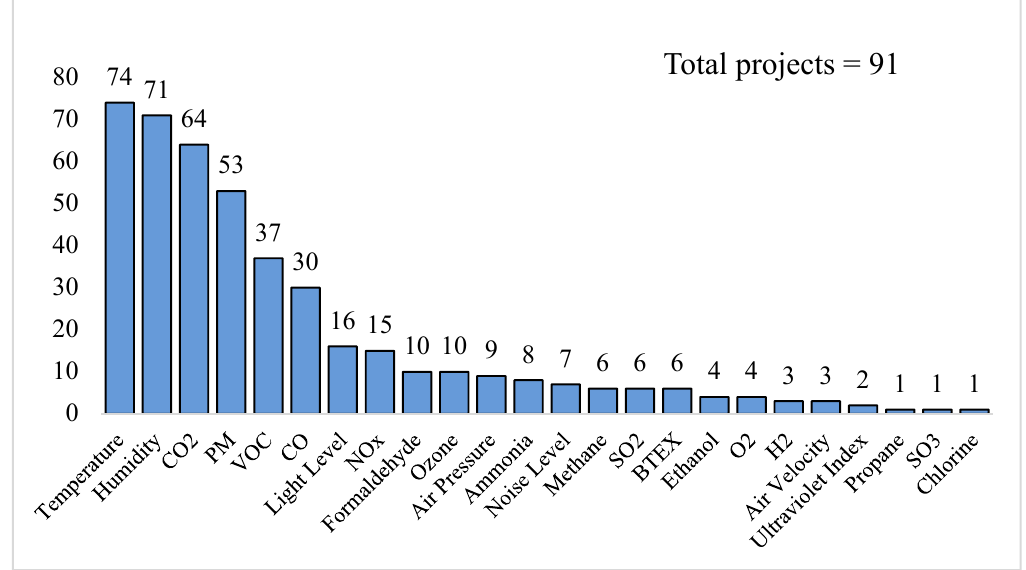
Figure 5. Monitoring parameters in the reviewed projects.